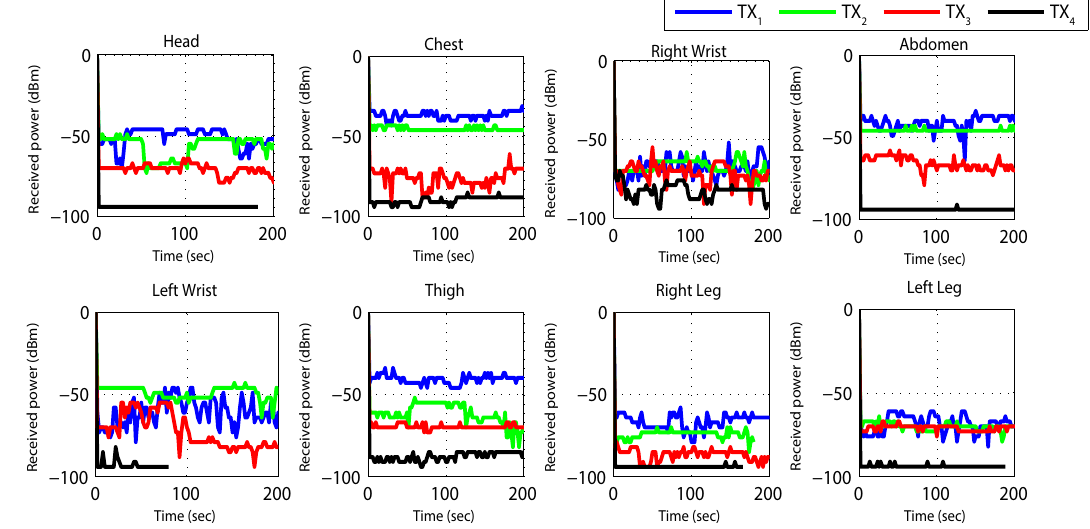
Figure 18. RX power based on default TX power while sitting activity.